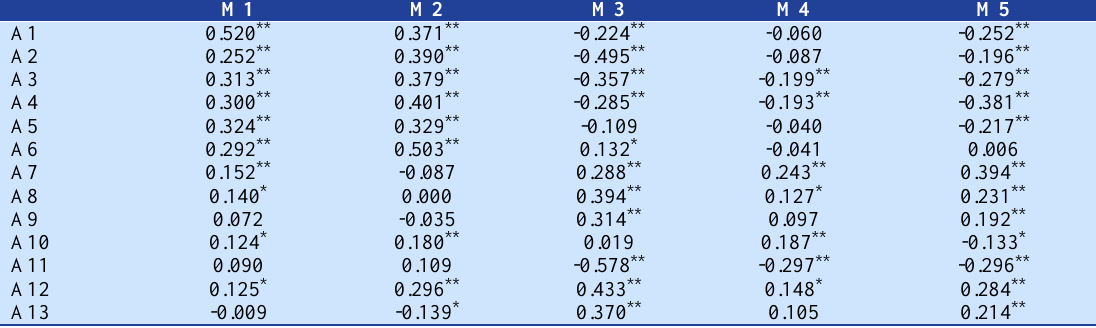
Table 7. Correlation between accident causing operations (As) and safety measures practiced